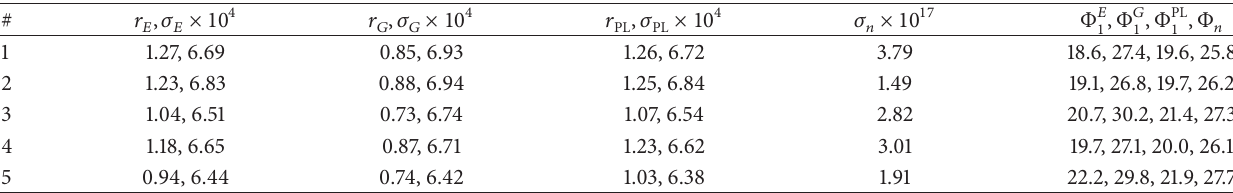
Table 5: Five Monte Carlo runs for the 1D Ising model. The “true” correlation function is exponential with 𝑟 = 1.19 and 𝜂 = 0.119 and yields Φ th = 19.5 . The correlation functions extracted from the generated rough surfaces were fitted with the exponential, Gaussian, and power 𝐸 law functions. The Table contains the best fitting values of 𝑟 𝐸,𝐺, based on the Ising model with spins ±1 , the best fitting values of 𝜂 differed from 0.119 by less than 1% for all fitting functions. The values of Φ 𝑛 were obtained by direct spectral decomposition of the raw correlation data. The size of the sample was Metropolis cycles.